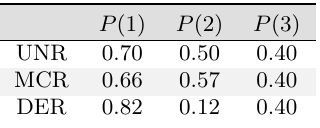
Table 3: Marginal probabilities for the 3 × 3